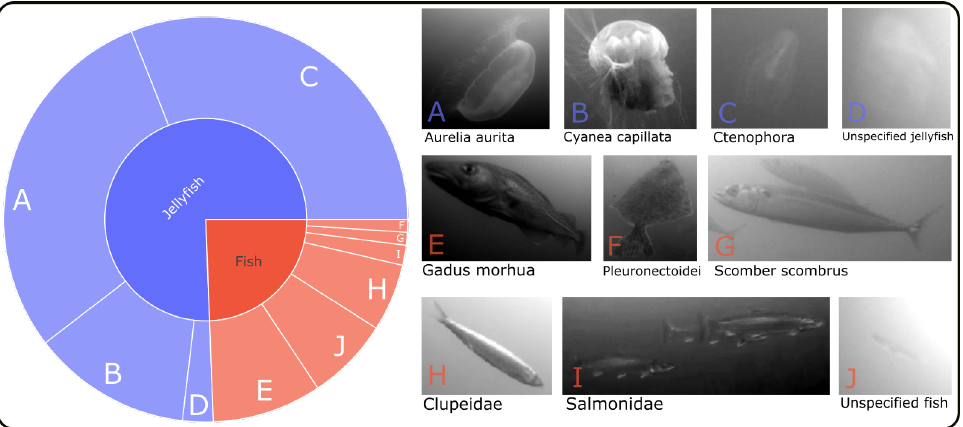
Figure 2. The distribution of classes among the 92,899 bounding box annotations in the used dataset. Included are ten different object categories, with roughly 75% of the samples consisting of four different types of jellyfish and the remaining 25% falling into six categories of